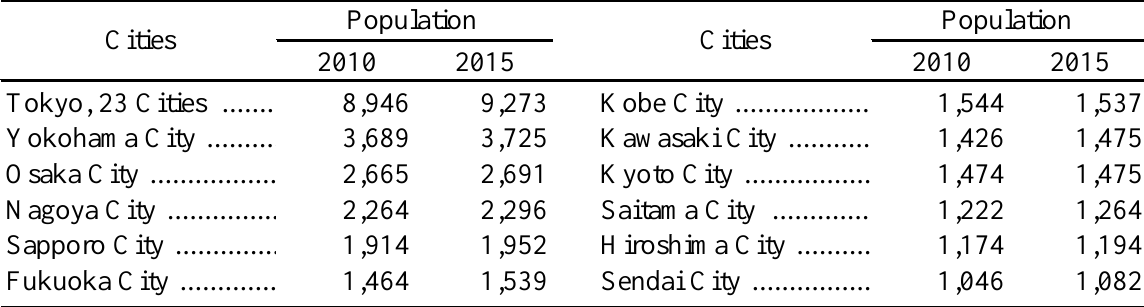
Population of Major Cities